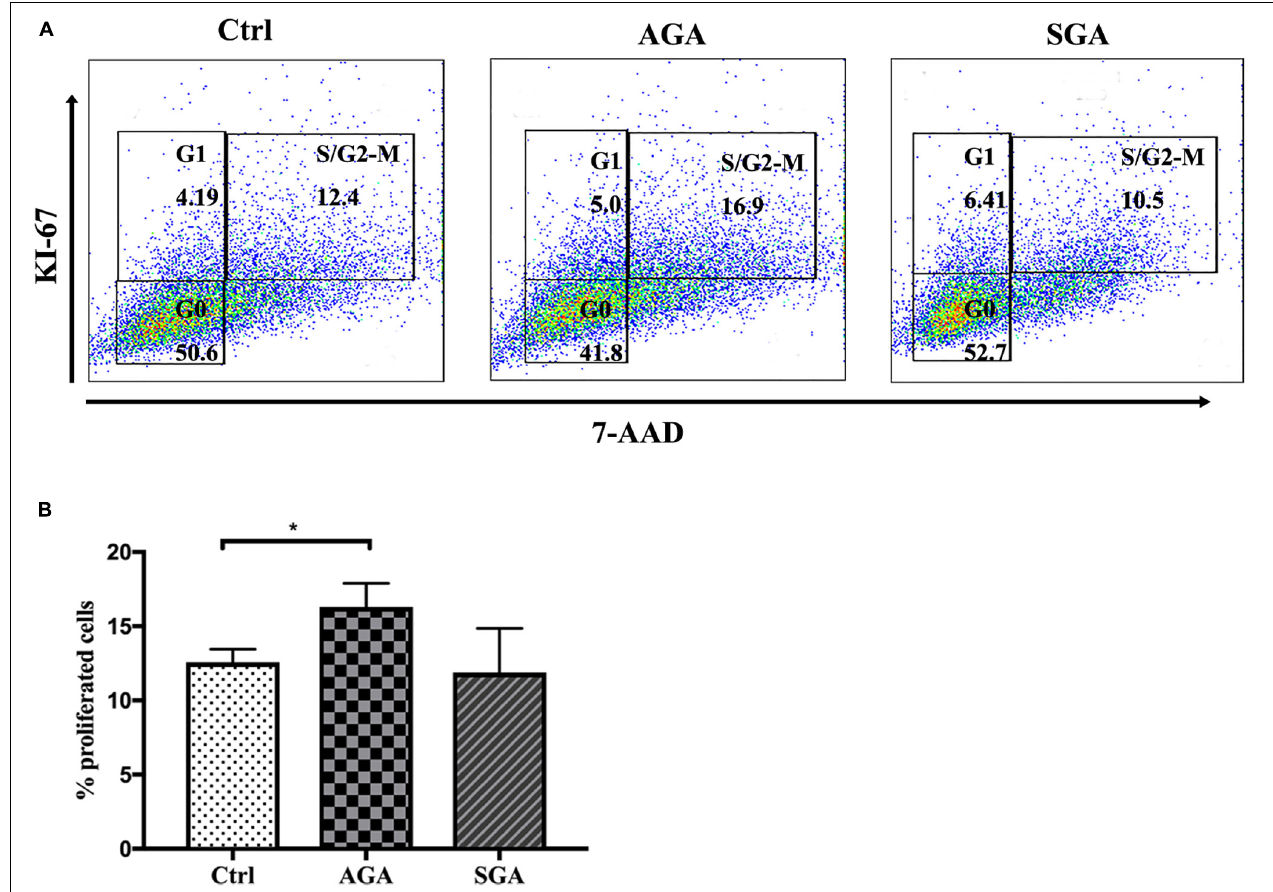
FIGURE 5 | The effect of dNK cells on trophoblast proliferation. (A) Representative flow cytometry analysis of the expression of proliferating cells (S/G2-M) in complete medium (Ctrl), and when co-cultured with dNK cells in AGA (AGA), or SGA (SGA), respectively. (B) Statistical analysis of proliferating cells in the three different groups ( n = 5). * p <